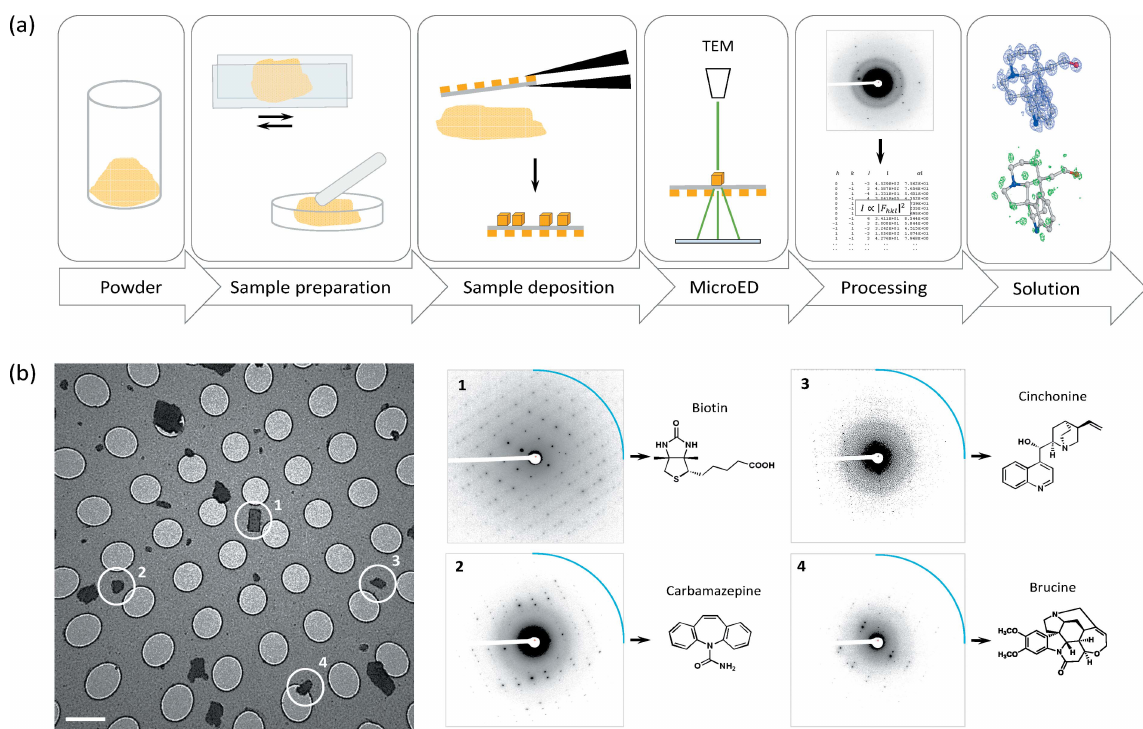
Figure 4 MicroED for small-molecule research. ( a ) Typical workflow involved for MicroED of small-molecule samples from powder to individual crystals on a standard EM grid, data collection, processing and structure solution. The solved structure in the last panel shows the model of the compound limaspermidine with the observed map showing the individual atoms (blue, top), and the difference map showing hydrogen atom positions (green, bottom). ( b ) Individual compounds can be identified from heterogeneous mixtures using MicroED. Resolution rings are shown at 0.8 A˚ (blue).